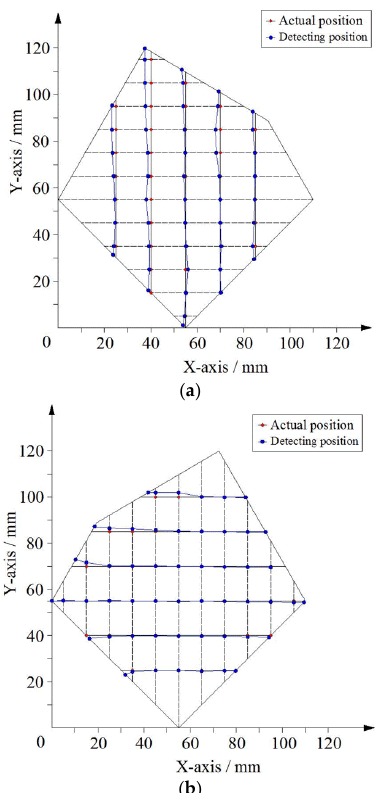
Figure 16. Experimental results for point contact. ( a ) Bias voltage applied in the direction of X-axis. ( b ) Bias voltage applied in the direction of Y-axis.